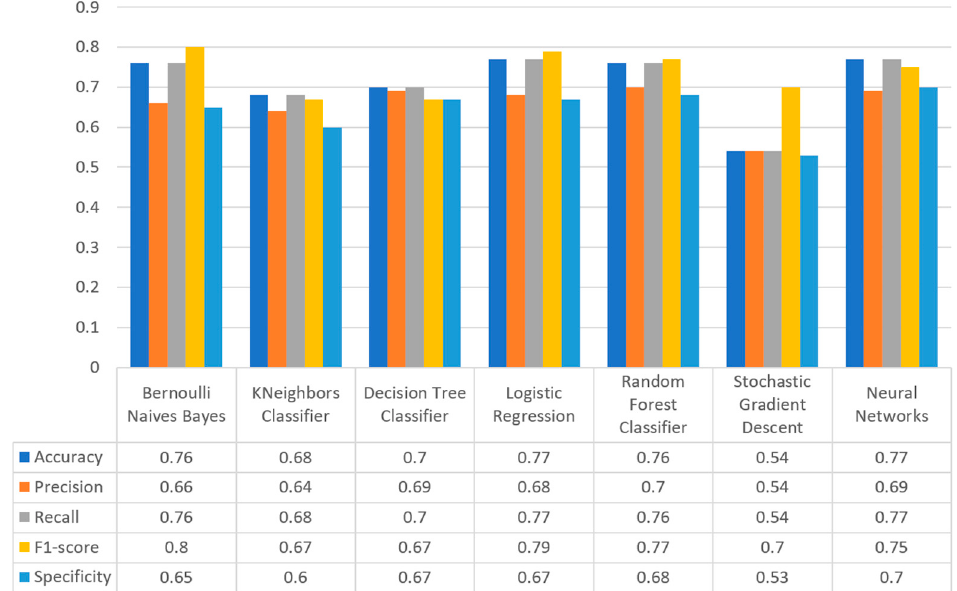
Figure 17. Performance comparison in the diabetes use case.